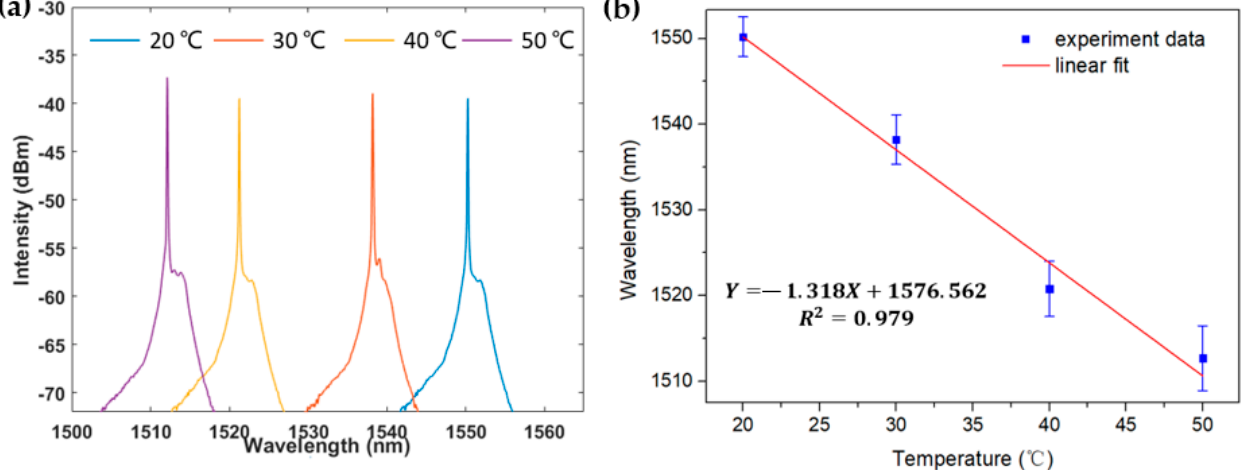
Figure 8. Temperature response of the LC filled HCF structure in FRL. ( a ) Transmission spectra of the fiber laser temperature sensor system when T changes from 20°C to 50°C with the steps of 10°C. ( b ) Variations of the emission wavelength.